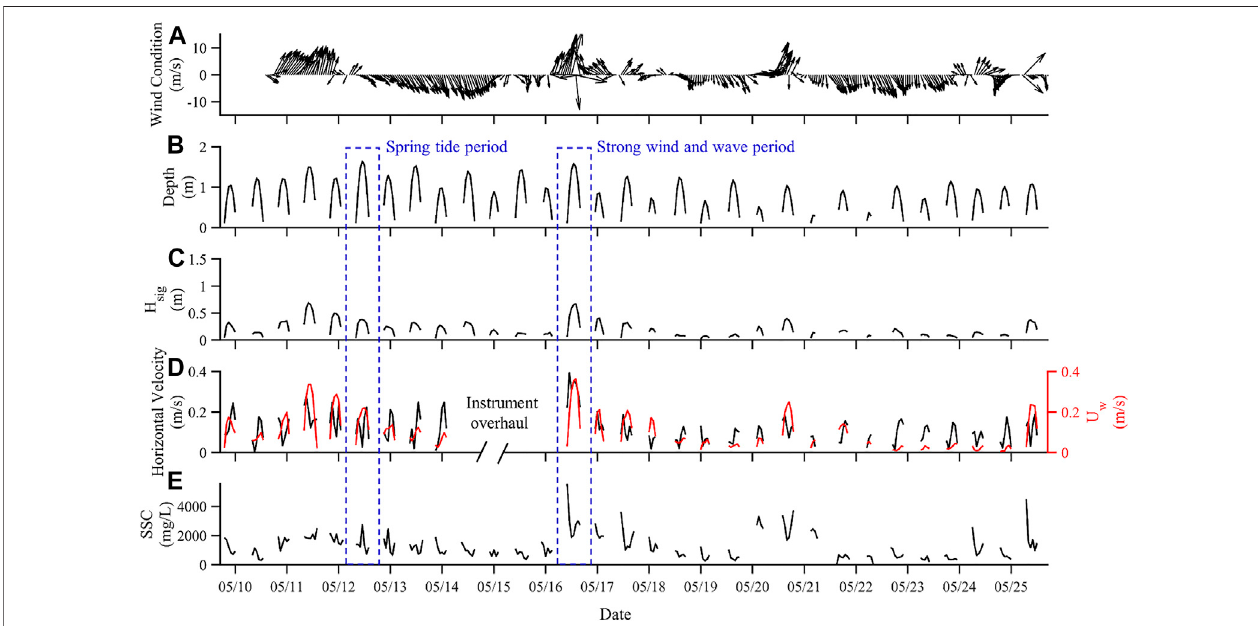
FIGURE6| Timeseriesofhydrodynamicsandsuspendedsedimentconcentrationsinthestudyarea: (A) windspeedanddirection; (B) waterdepth; (C) signi fi cant waveheight; (D) current velocity at 15 cmabove the bottom (data on 15th May are lackingdue to instrument overhaul); (E) suspended sediment concentration (SSC) at the observation site during 10 – 25 May 2021.